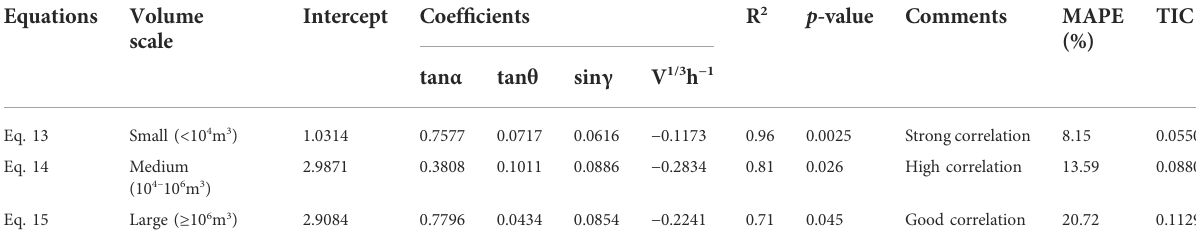
TABLE 5 The multiple linear regression results for de fl ection-type rock avalanches with different landslide scales.